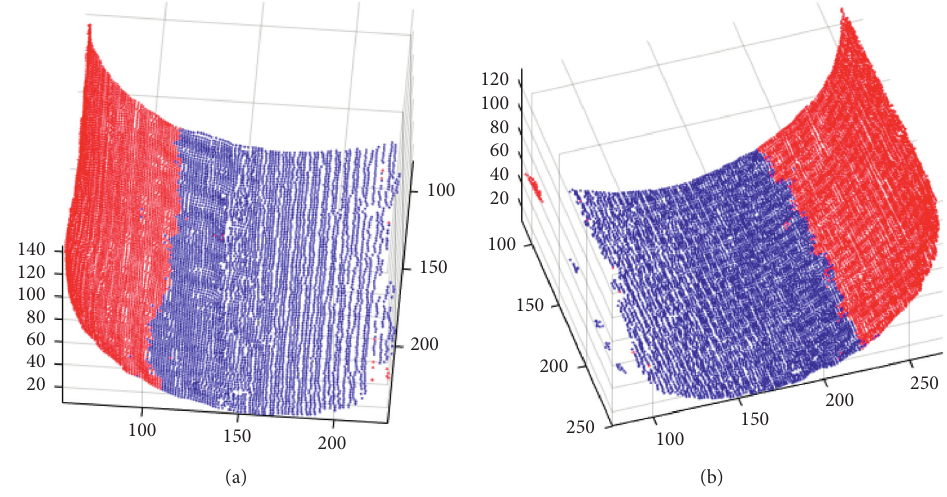
Figure 14: Common parts extracted by